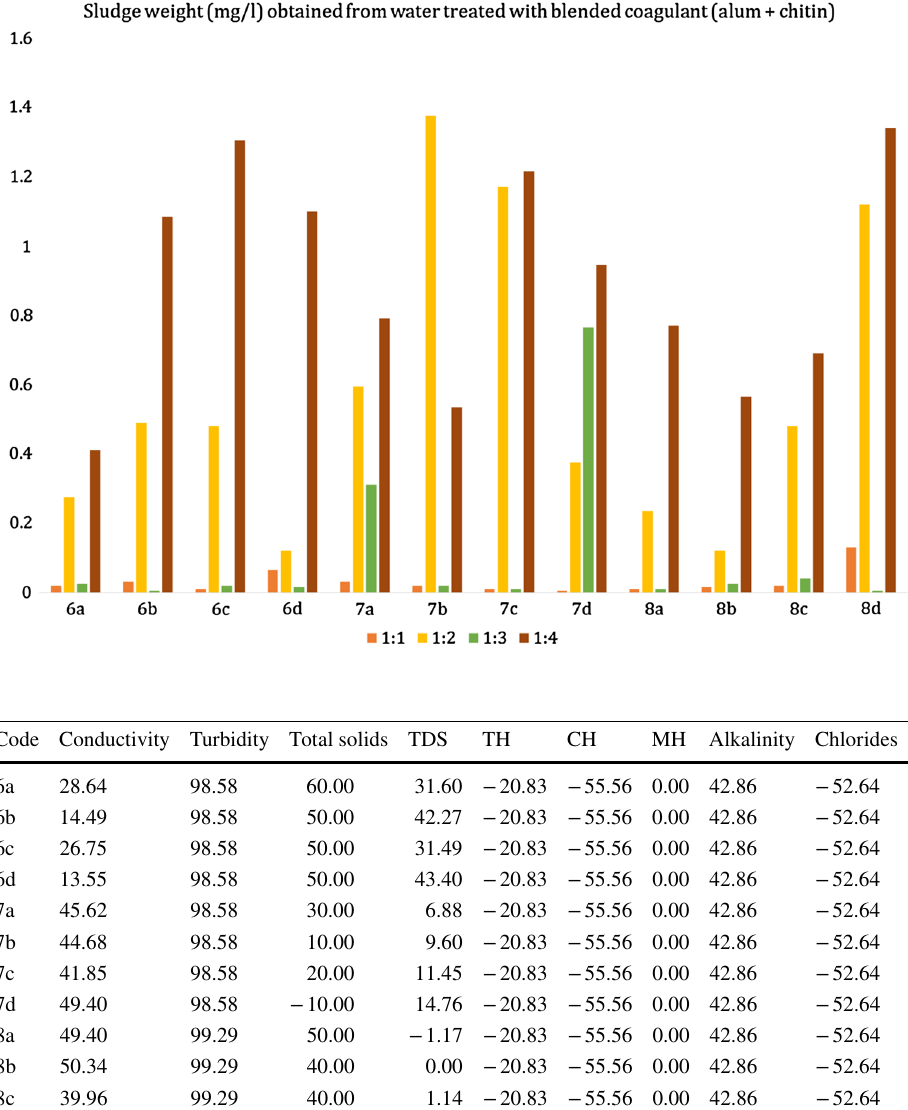
Fig. 2 Sludge weight (mg/l) obtained from water treated with blended coagulant (alum + chitin)